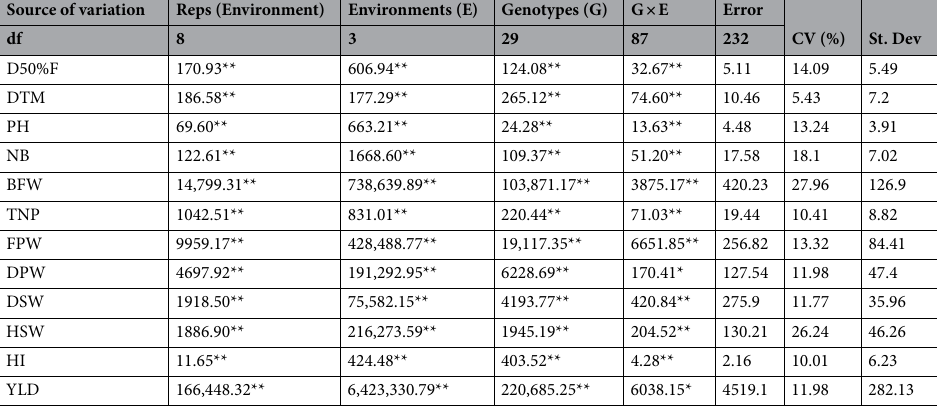
Table 4. The mean squares and significant level of vegetative, yield, and its related traits revealed by ANOVA. df = degrees of freedom, St. Dev = standard deviation, CV = coefficient of variation, * = significant (p ≤ 0.05),** = highly significant (p ≤ 0.05), D50%F = days to 50% flowering, DTM = days to maturiity, PH = plant height (cm), NB = number of branches , BFW = biomass fresh weight (g), TNP = total number of pods, FWP = fresh pods weight (g), DPW = dry pods weight (g), DSW = dry seeds weight (g), HSW = hundred seed weight (g), HI = harvest index, and YLD = yield